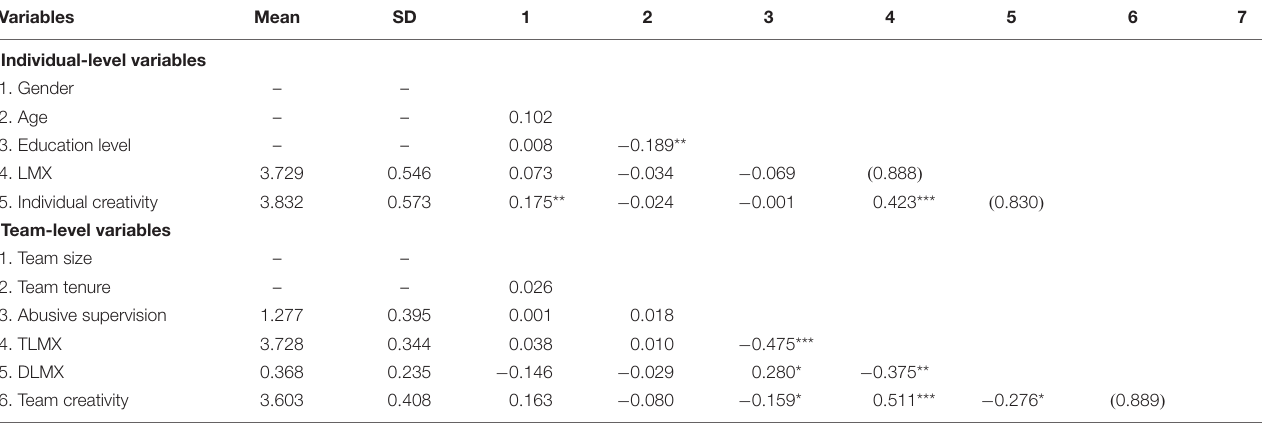
TABLE 1 | Means, standard deviations, and correlations.